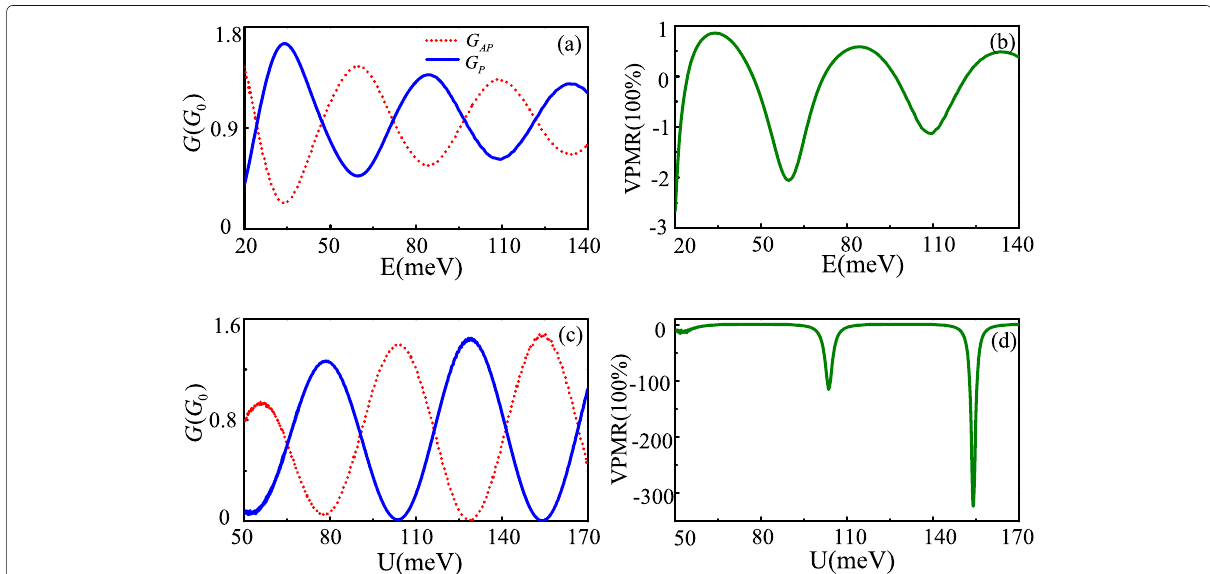
Fig. 3 Conductance G P , AP ( a , c ) and VPMR ( b , d ) as functions of the Fermi energy and the electric barrier at L = 207 nm , v t = 0.02 v f . the other parameters are U = − 10 meV for a and c , E = 80 meV for b and d (color